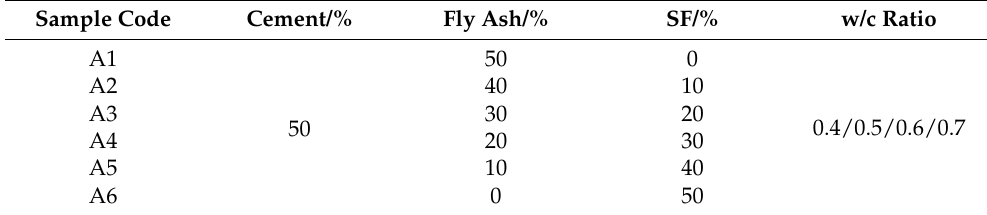
Table 2. Proportion of cement paste in the experiment. Sample